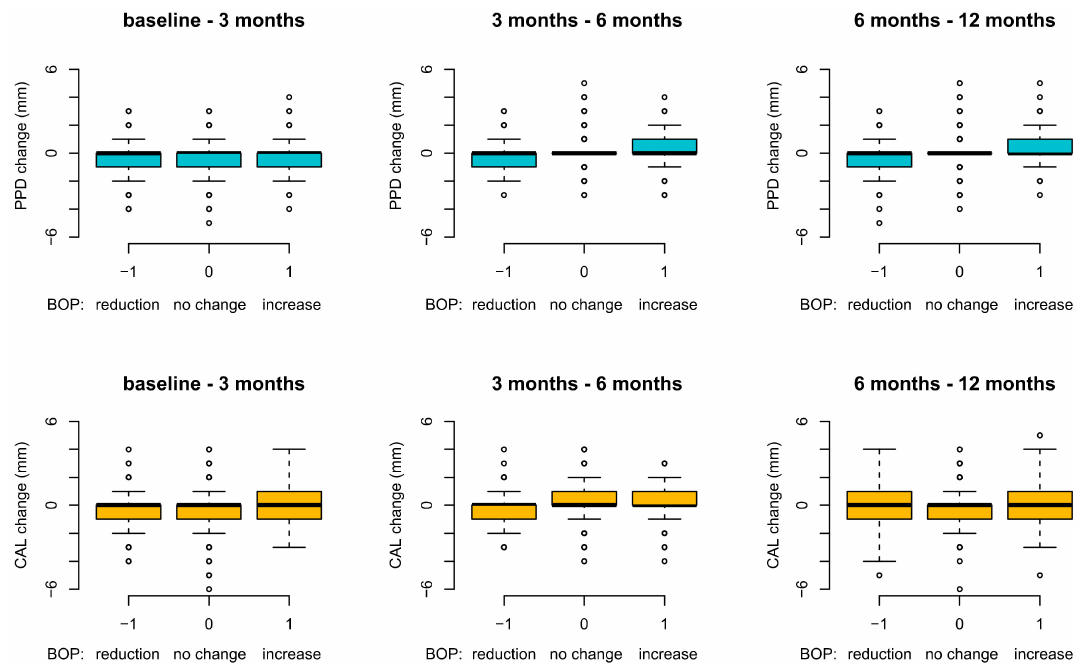
Figure 2. Site-based analysis: PPD and CAL changes in relation to BOP over 12 months (BOP: bleeding on probing; PPD: probing pocket depth; CAL: clinical attachment